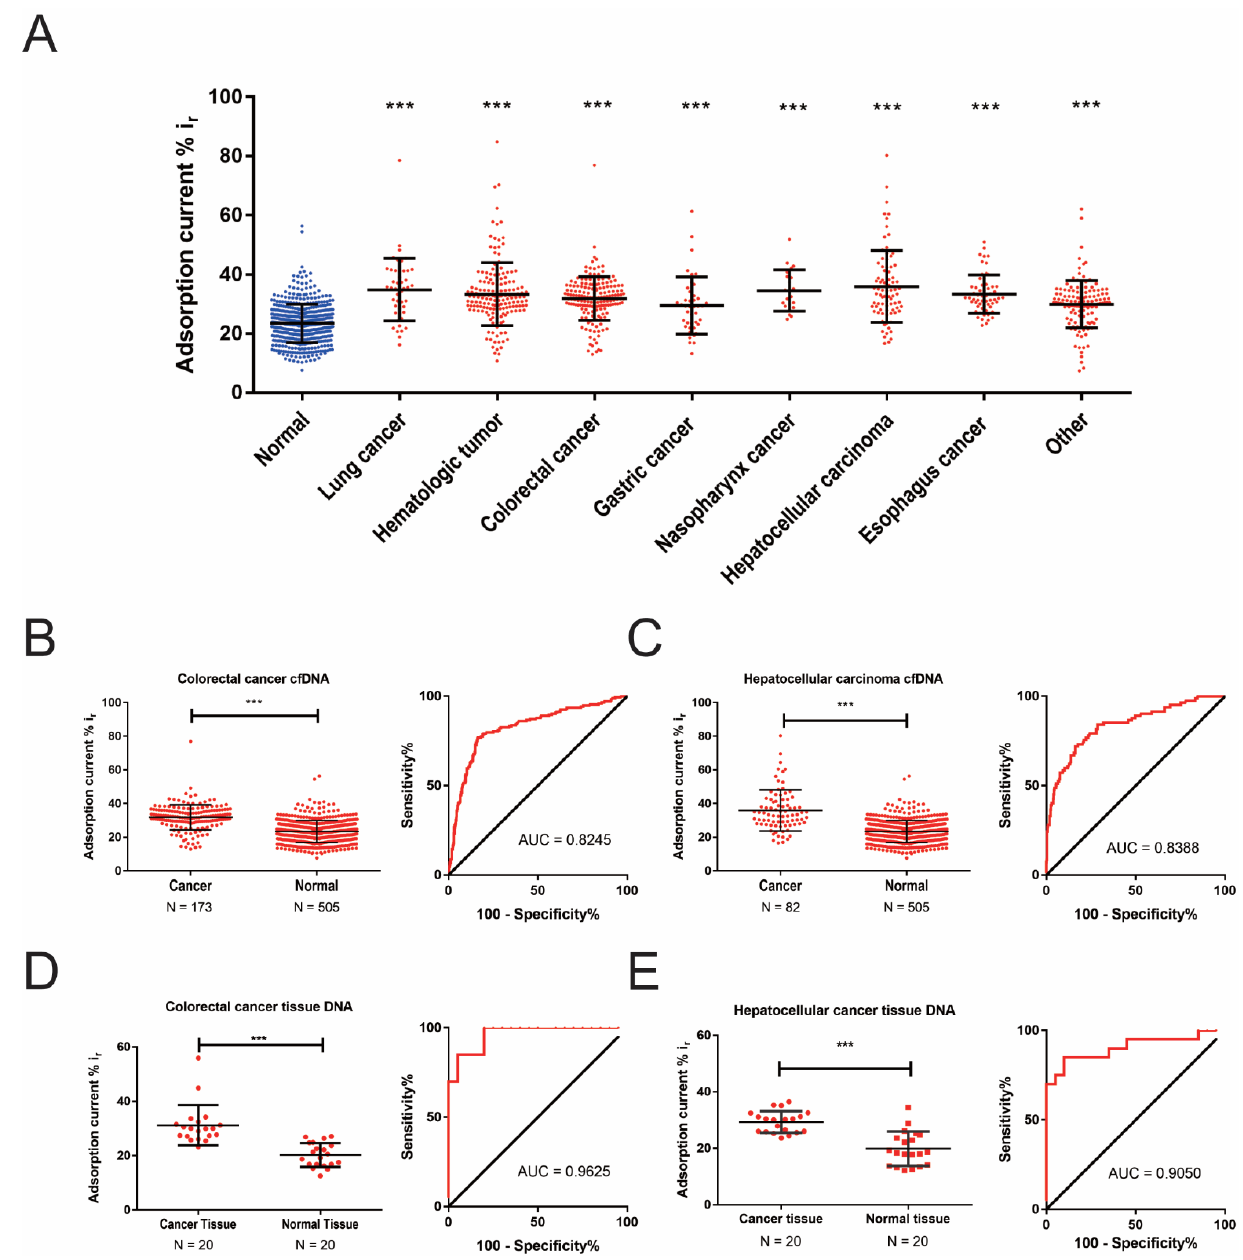
Figure 3. Application of electrochemical methylation detection in tissue and plasma circulating free DNA (cfDNA). ( A ) The scatter plot shows the electrochemical detection of the current adsorption rate of cfDNA from normal people, lung cancer, hematological cancer, colorectal cancer, gastric cancer, nasopharynx cancer, hepatocellular cancer, esophagus cancer and other cancers. ( B ) The scatter plot shows the current adsorption rate of cfDNA from colorectal cancer patients and normal people. Receiver operating characteristic (ROC) curve of the diagnostic efficacy of the cfDNA adsorption rate in colorectal cancer. ( C ) The scatter plot shows the current adsorption rate of cfDNA from hepatocellular cancer patients and normal people. ROC curve of the diagnostic efficacy of the cfDNA adsorption rate in hepatocellular cancer. ( D ) The scatter plot shows the current adsorption rate of tissue DNA from colorectal cancer and normal people. ROC curve of the diagnostic efficacy of the tissue DNA adsorption rate in colorectal cancer. ( E ) The scatter plot shows the current adsorption rate of tissue DNA from hepatocellular cancer and normal people. ROC curve of the diagnostic efficacy of the tissue DNA adsorption rate in hepatocellular cancer. *** p < 0.001.